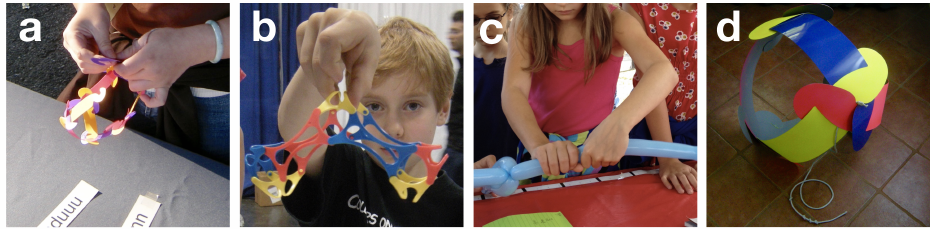
Figure 1. Fun with building shapes from code: ( a ) “Make a basket from a word”, ( b ) “Evolve a basket”, ( c ) “Evolve your own balloon animal”, ( d ) “Knots code